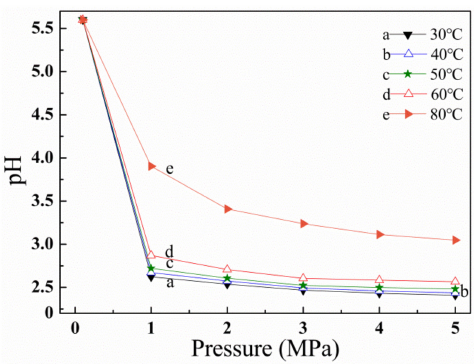
Figure 9. Polarization curves of the LDHs coatings at different formation times in 3.5% NaCl